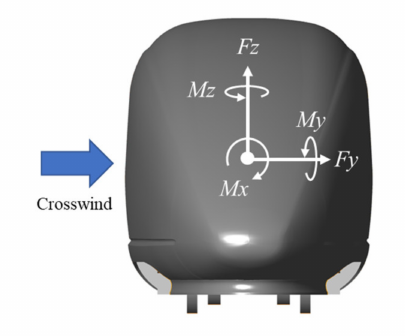
Figure 4. The parameter definition and the origin of the moment coordinate